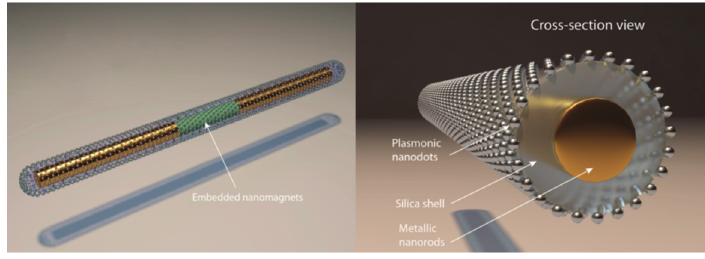
Figure 5. Structure of a tri-layer nanocapsule [71]. With permission from